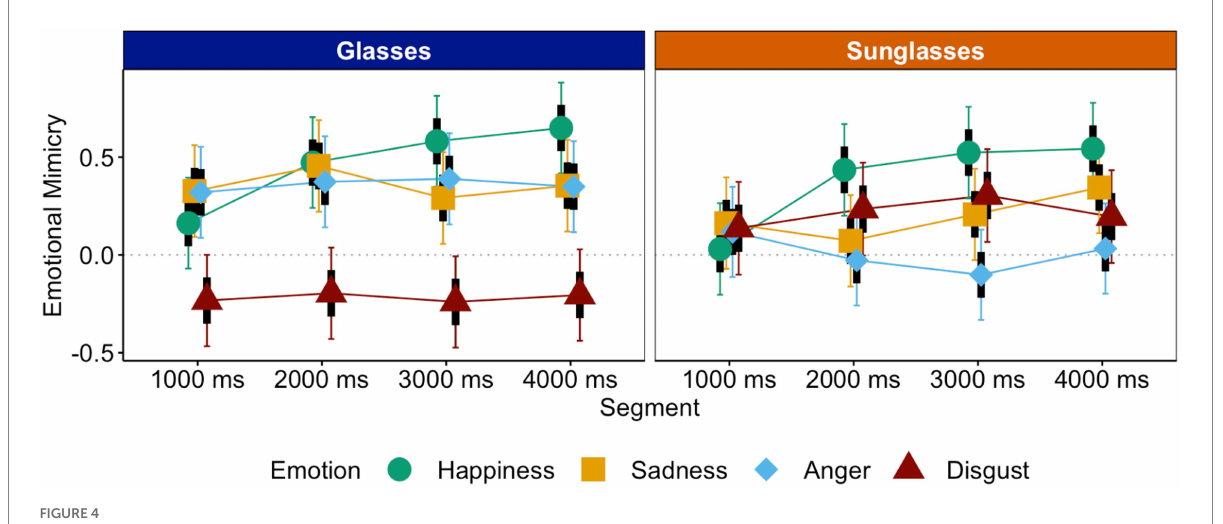
FIGURE 4 Emotional mimicry as a function of eye contact, segment, and